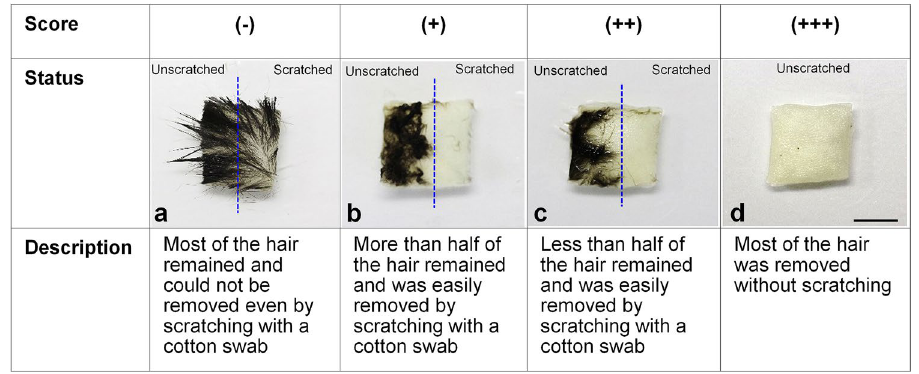
Figure 1. Rating scale system for evaluating the effectiveness of the hair removal treatment effects. Scale bars: 5